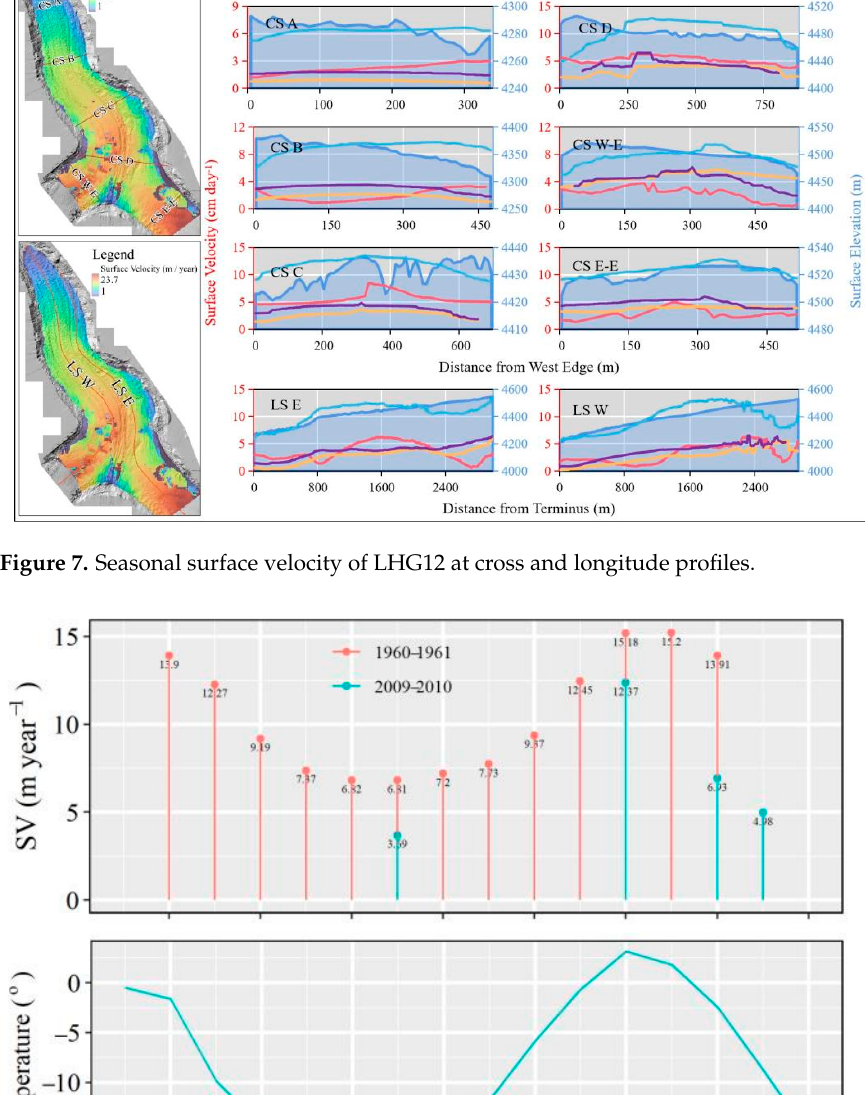
Figure 9. Surface velocities of LHG12 during 2010–2013 (EB: east branch; WB: west branch). 3.4. Changes of Surface Elevation In 2018–2019, ice surface elevation of the survey area decreased by an average of 1.22 m. In 2019–2021, it by an average decreased 3.28 m, decreasing by about 1.65 m per year (Figure 10). The characteristics of surface elevation difference results were quite different between east and west branches. In the monitoring area, the area of western branch was larger than that of the eastern branch. The regions in which the elevation increased were